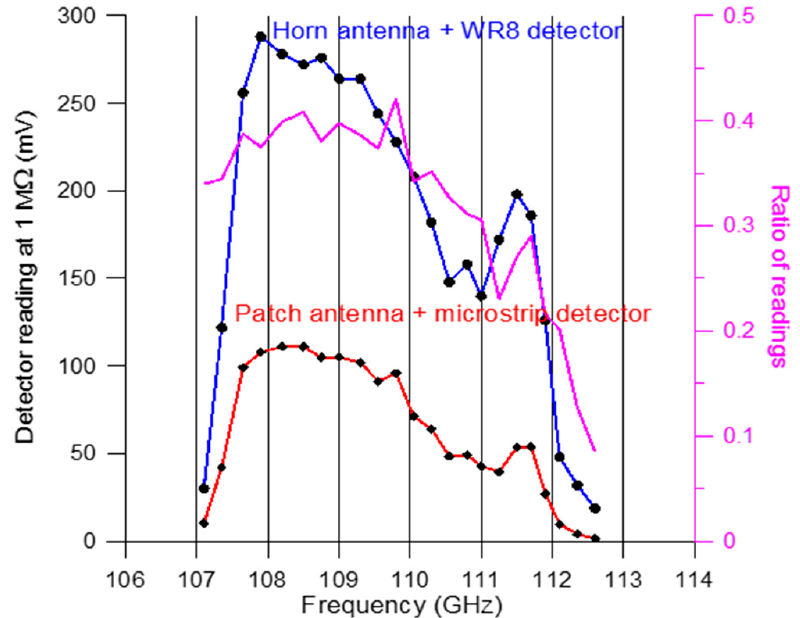
Figure 4. Readings of the SAGE Millimeter detector connected to the horn and of the patch antenna coupled to RadiaBeam’s microstrip detector versus frequency of the source with an uncalibrated power characteristic. The ratio of readings indicates that the RadiaBeam detector together with the patch antenna is narrower band compared to the SAGE detector with the horn antenna.